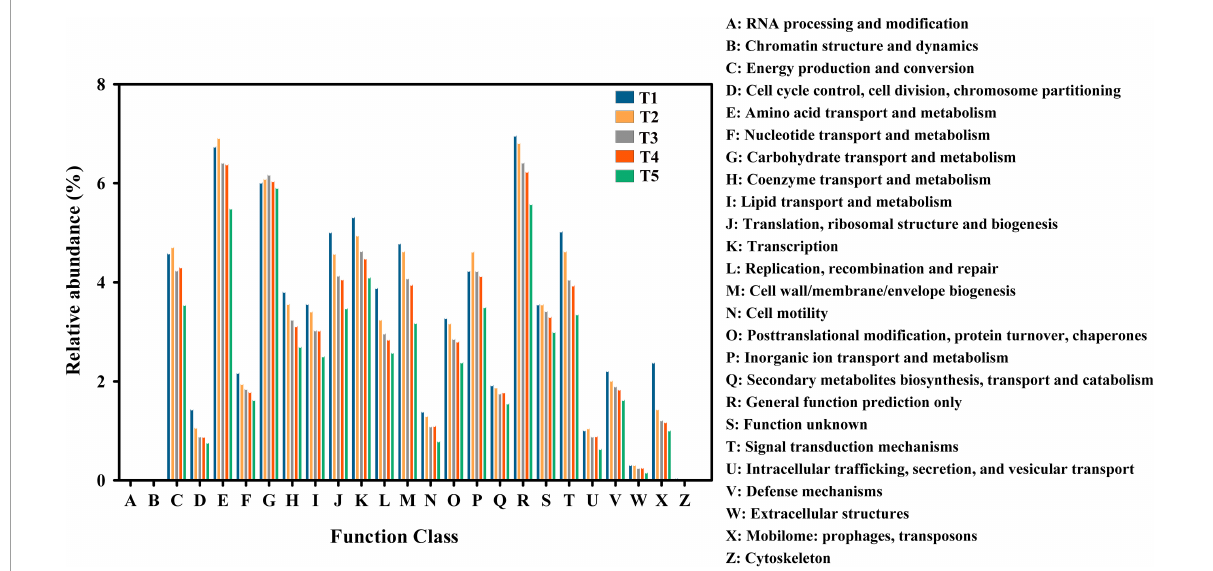
FIGURE6 Cluster of Orthologous Groups of proteins (COG) classification. The abscissa is the COG entry, and the ordinate is the relative abundance of COG genes with different functions in composting substrate at the different growth stages of oyster mushroom. T1, T2, T3, T4, and T5 indicate the day on which composting was completed (day 0: before spawning), mycelial colonization (day 3), mid-incubation (day 10), end-incubation (day 20: before primordia formation), and first oyster mushroom fructification (day 30: fruiting body development), respectively.